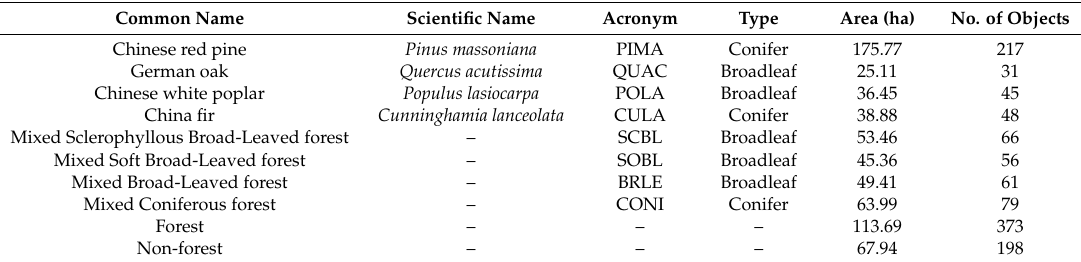
Table 5. Description of reference data for the hierarchical